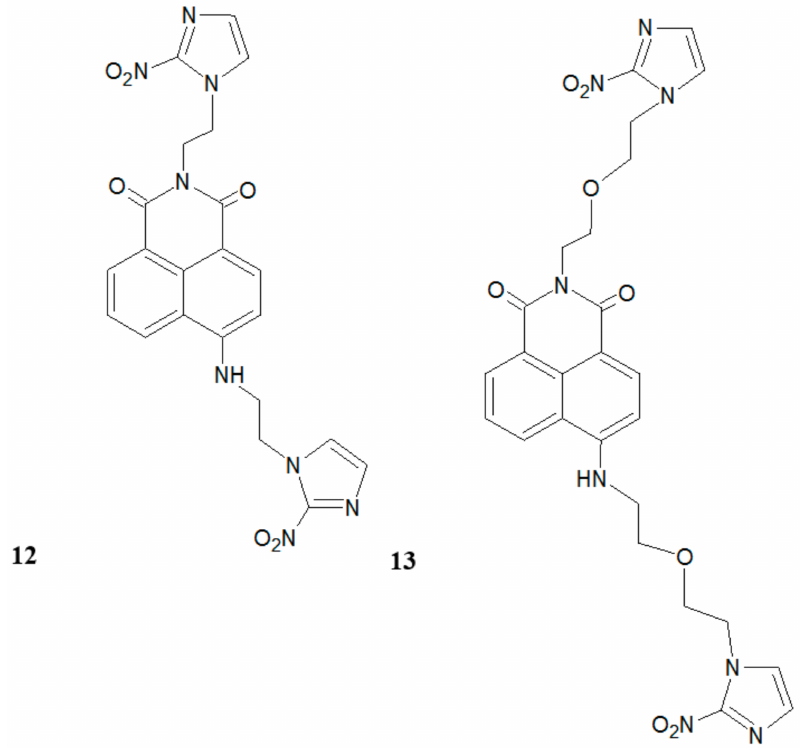
Figure 6. The structures of two bis-(2-nitroimidazole)-naphthalimides ( 12 , 13